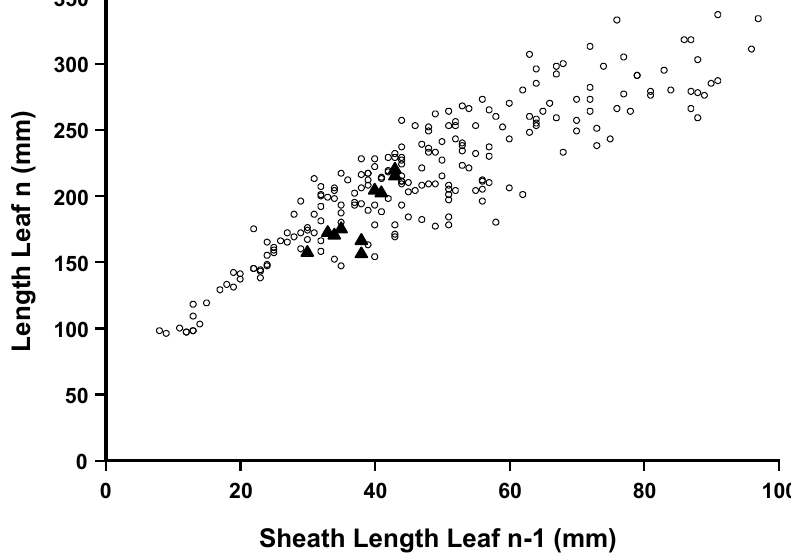
Figure 5. Relationship between the length of a tube sheath and the final length of the leaf that has emerged from the same tube on tillers (main and secondary tillers) of defoliated and undefoliated ryegrass ( Lolium perenne ). ( ◌ ): undefoliated plants; ( ▲ ): weekly defoliated plants. The source of variation in sheath and leaf length is the ontogenic development (successive leaves on main and secondary tillers). Redrawn from